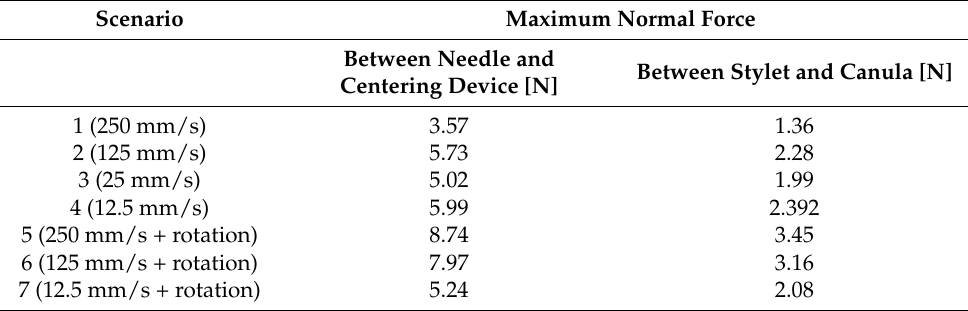
Table 4. Normal forces acting on the needle maximum values. Scenario Between Needle